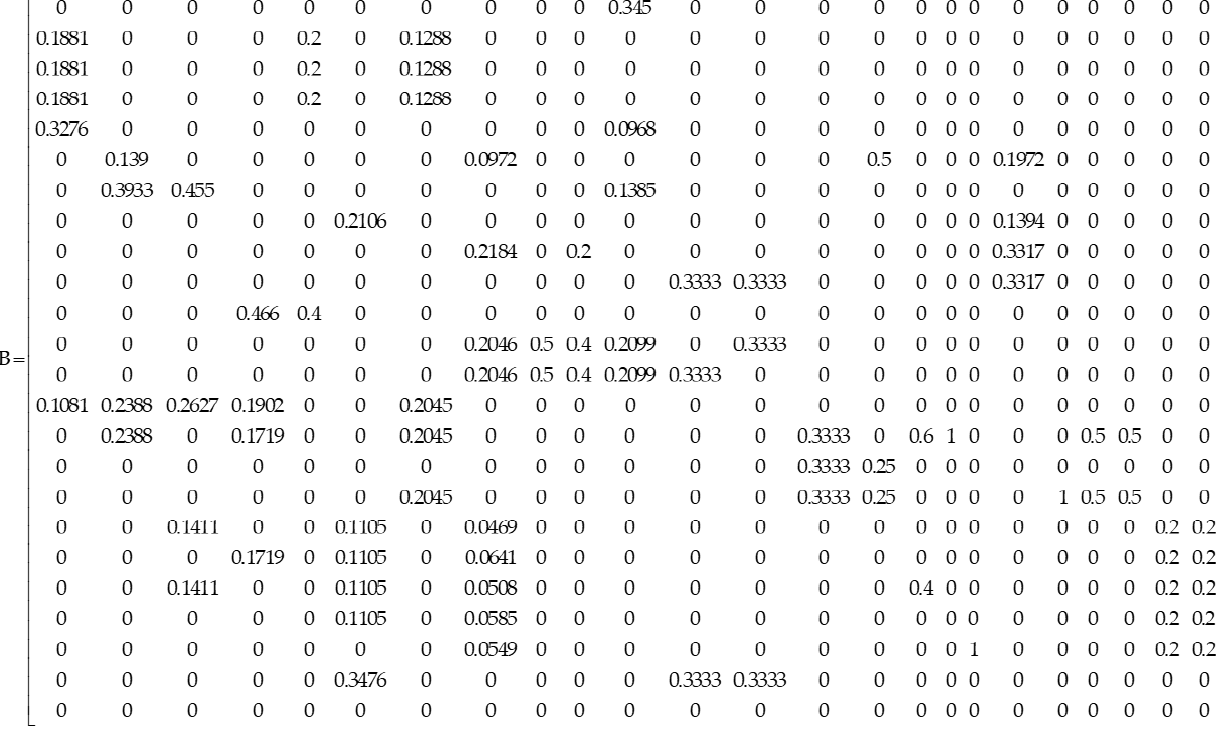
Figure 4. Weight relationship matrix between indicator elements of community emergency assess- ment.